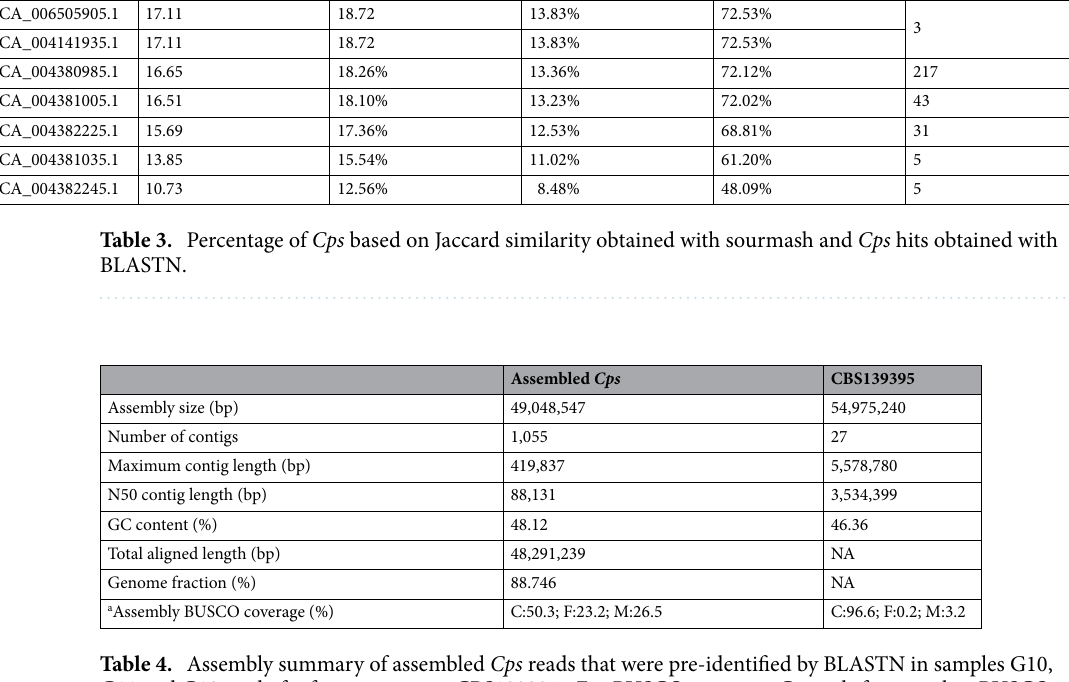
Table 4. Assembly summary of assembled Cps reads that were pre-identified by BLASTN in samples G10, G11 and G12, and of reference genome CBS139395. a For BUSCO coverage, C stands for complete BUSCOs, F stands for fragmented BUSCOs, and M stands for missing